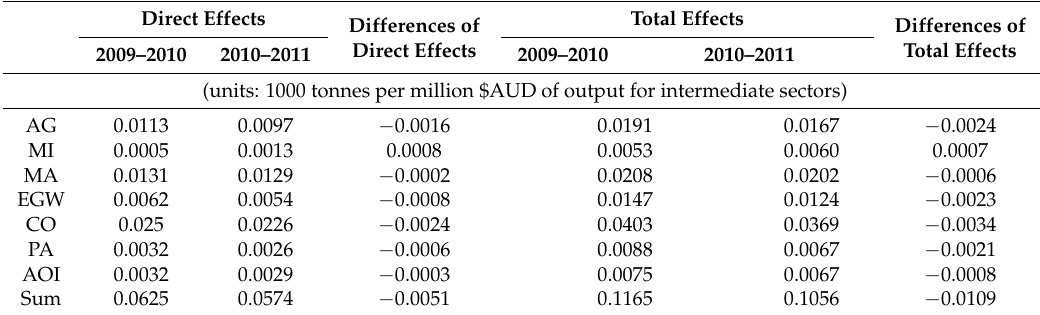
Table 13. Direct, total, and the change of direct and total effects of sectors on waste treatment method (Recovery) in the Australian economy.